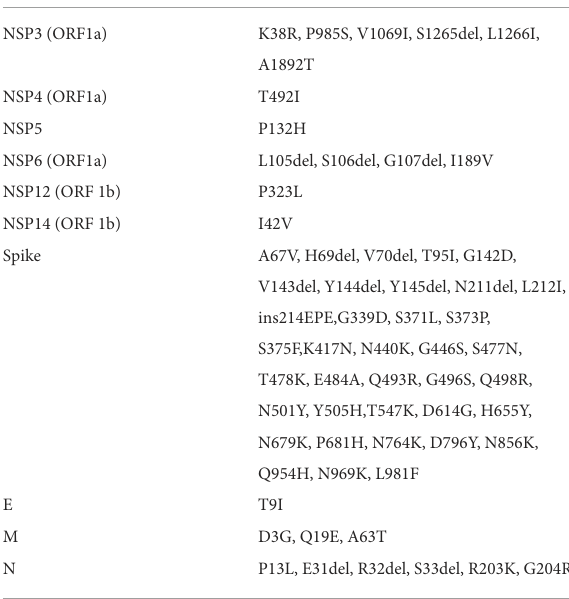
TABLE 2 List of mutations displayed in the different regions of the genome of SARS-CoV-2 in the sequence obtained in this study of Dog_8.